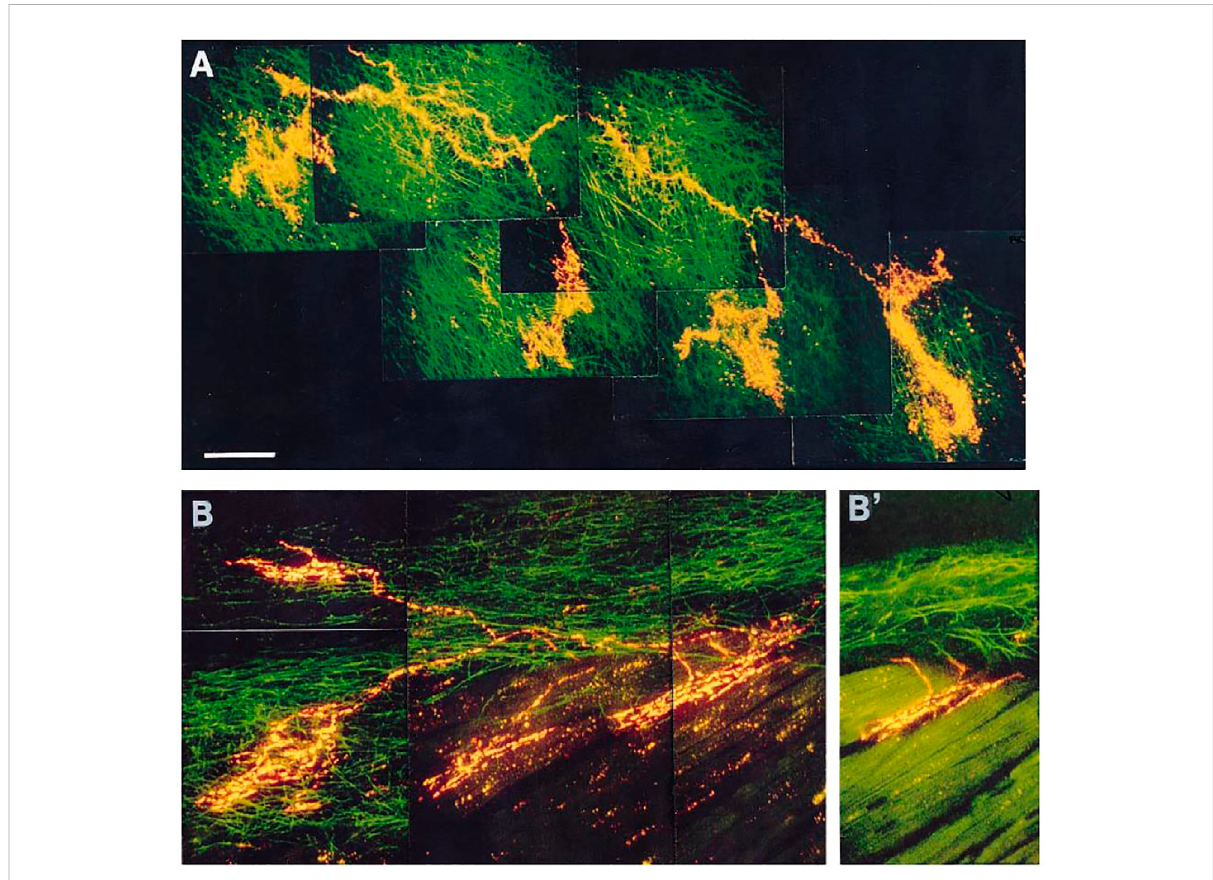
FIGURE 7 (A) : Receptive fi eld of a vagal afferent. A single afferent fi ber from the top left, covering a large receptive zone, makes four fl ower-sprays in the connective tissues of endocardium. (B) : Polymorphic receptive fi eld. A single afferent fi ber produces two intramuscular endings (IMEs, on the right) andtwo fl ower-sprays(ontheleft). (B) ’ :AnopticalsectionfrompanelBindicatingthattheIMEsareparallel-elongated.[Figure4(Chengetal.,1997)].